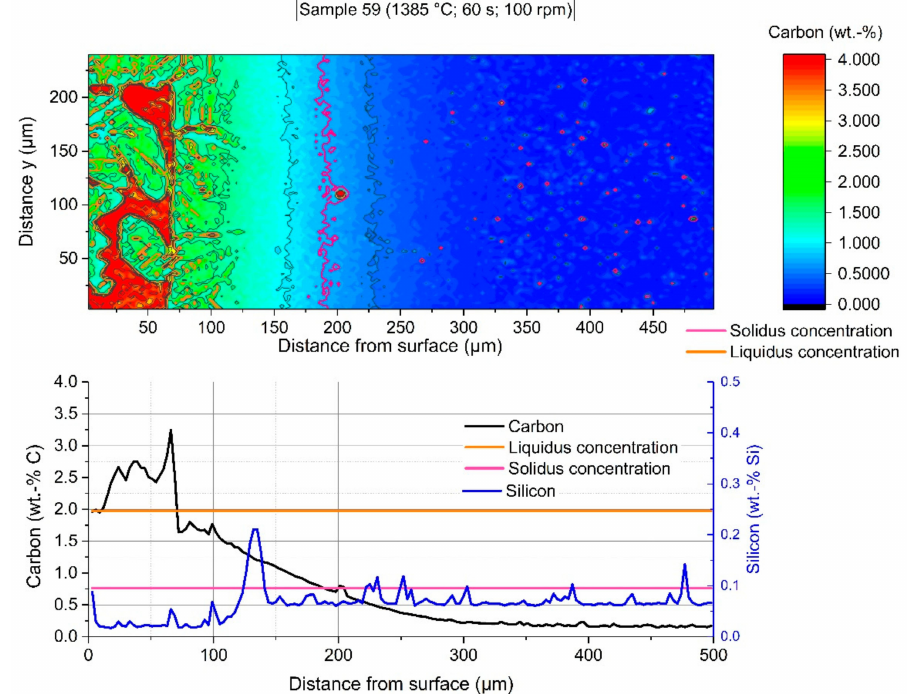
Figure 16. EPMA-measured carbon distribution of sample 59 with an immersion time of 60 s at 1385 ◦ C equilibrium temperature and turbulent bath